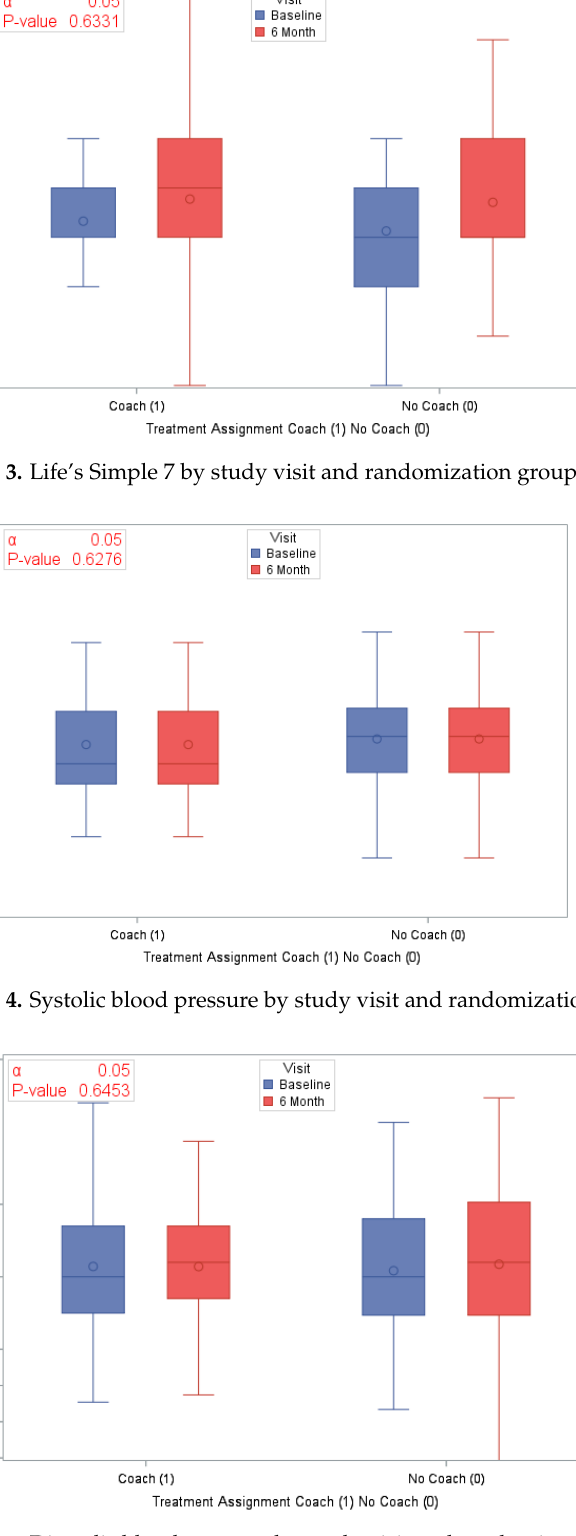
Figure 5. Diastolic blood pressure by study visit and randomization group.